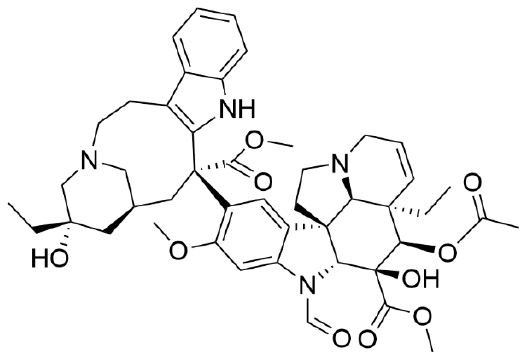
Figure 1. Chemical structure of vincristine.